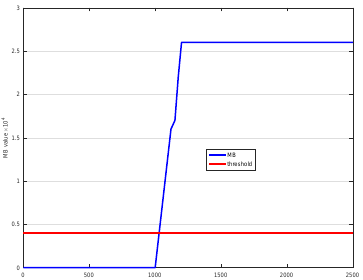
Figure 2. STUKF and Modified Bayes’ classification algorithm ( MB )-based detection for jump type